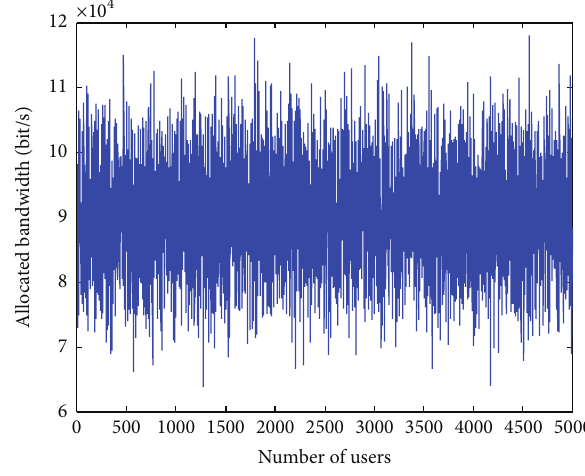
Figure 6: Variation with MBAC